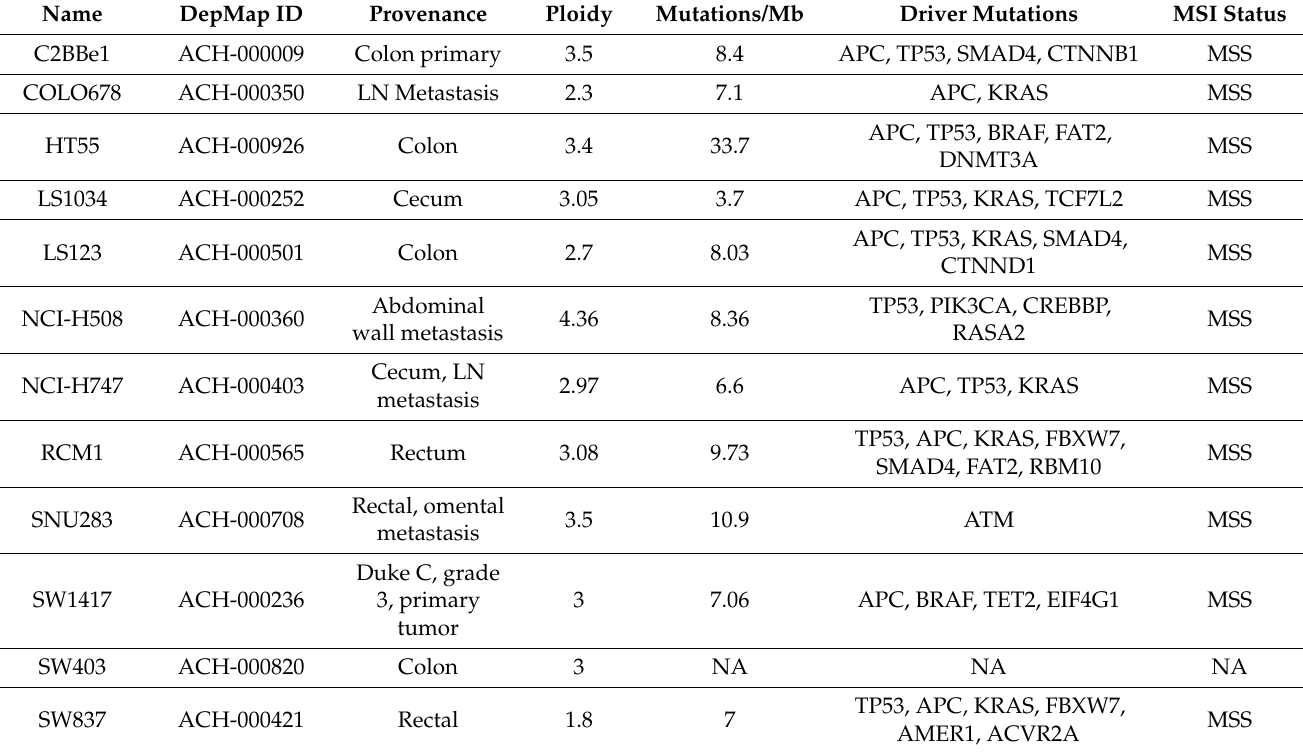
Table 1. Cell lines with 20q11.21 amplifications in CCLE. Twelve cell lines have amplifications of 20q11.21 genes in cBioportal. Information for the cell line characteristics is from Cell Model Passports. LN: Lymph node, MSI: Microsatellite instability, MSS: Microsatellite stable.